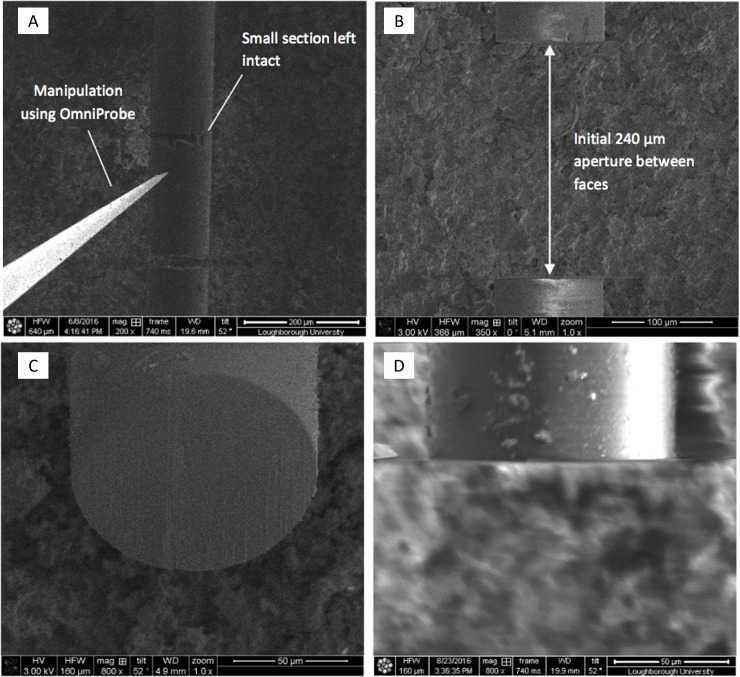
a) manipulation of embedded fiber using OmniProbe coaxial needle b) aperture produced via fibre manipulation at initial 240-μm distance c) and d) optical surfaces post ion-beam polishing.